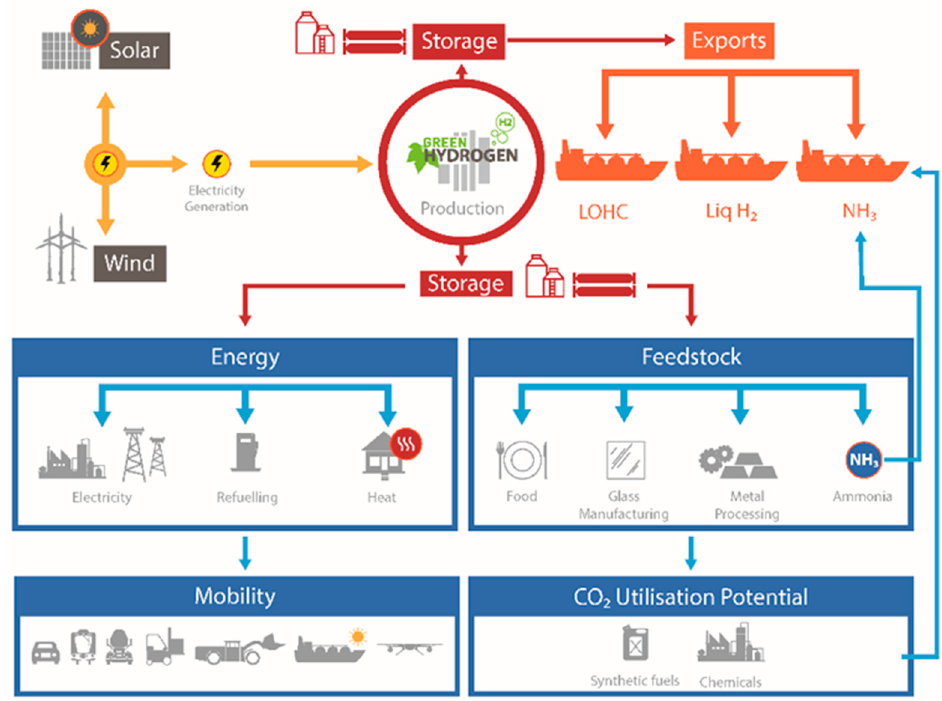
Figure 1. Hydrogen potential as an enabling chemical for various applications (reproduced from [43] with permission from Elsevier).